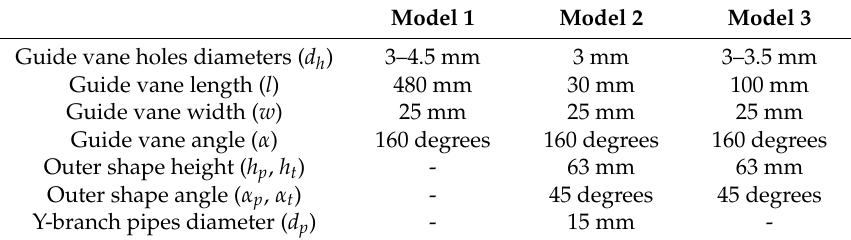
Figure 3. The inner and outer shapes of three new gas torch models: ( a ) model 1; ( b ) model 2; ( c ) model 3. Table 2. The dimensions of inner and outer shapes of the three new models.